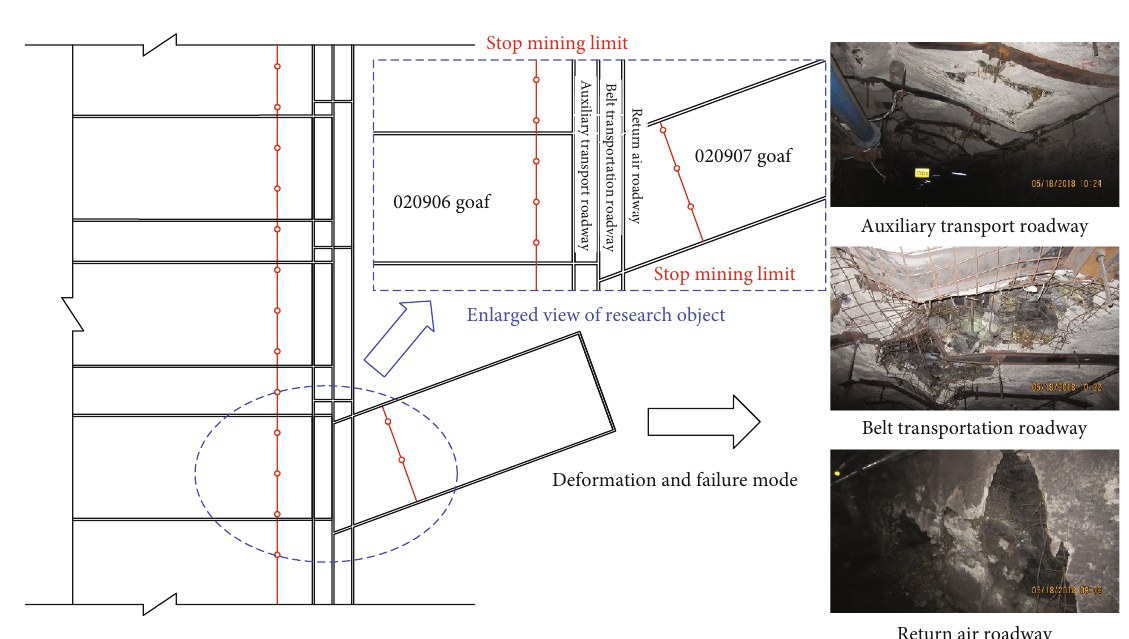
Figure 9: Roadway position and deformation and